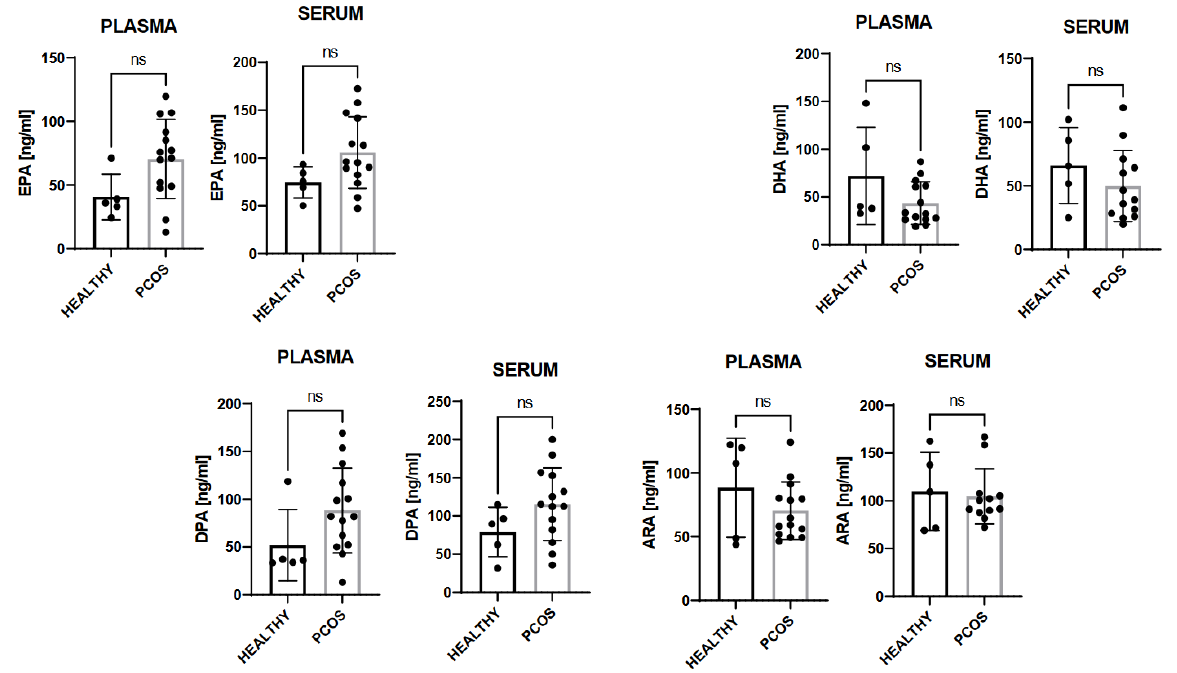
Figure 2. Results of the quantified free-fatty-acid precursors of resolving mediators. Ns = not significant.